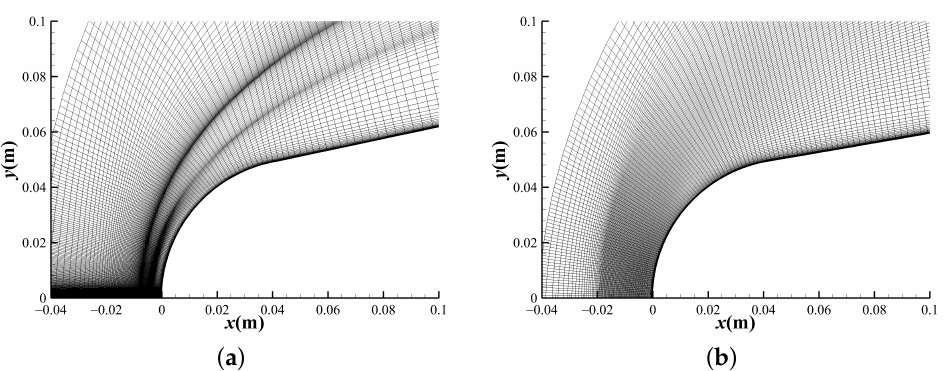
Figure 9. Computational meshes: ( a ) Mesh A. ( b ) Mesh